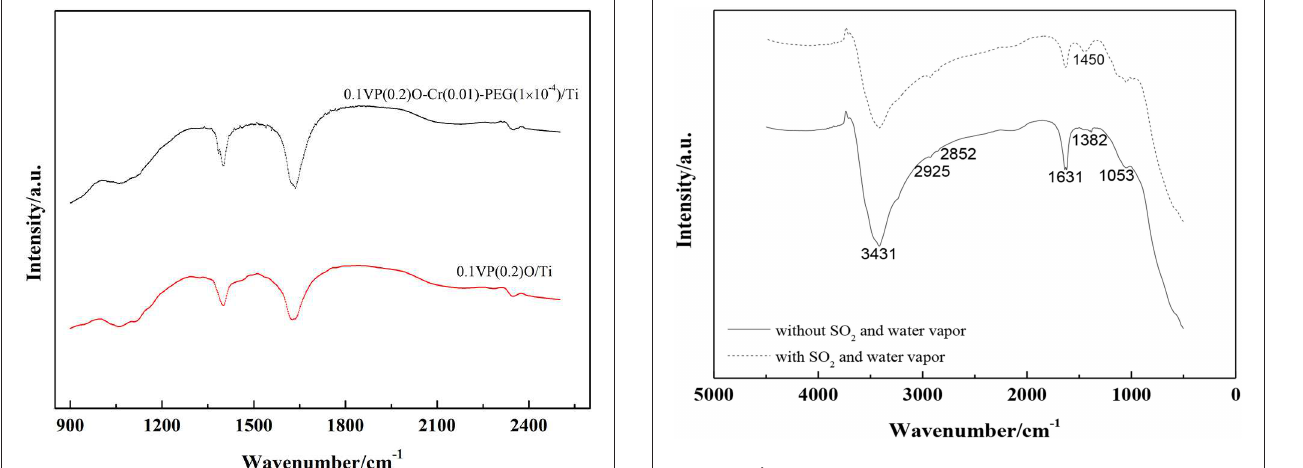
FIGURE 13 | FT-IR spectra of